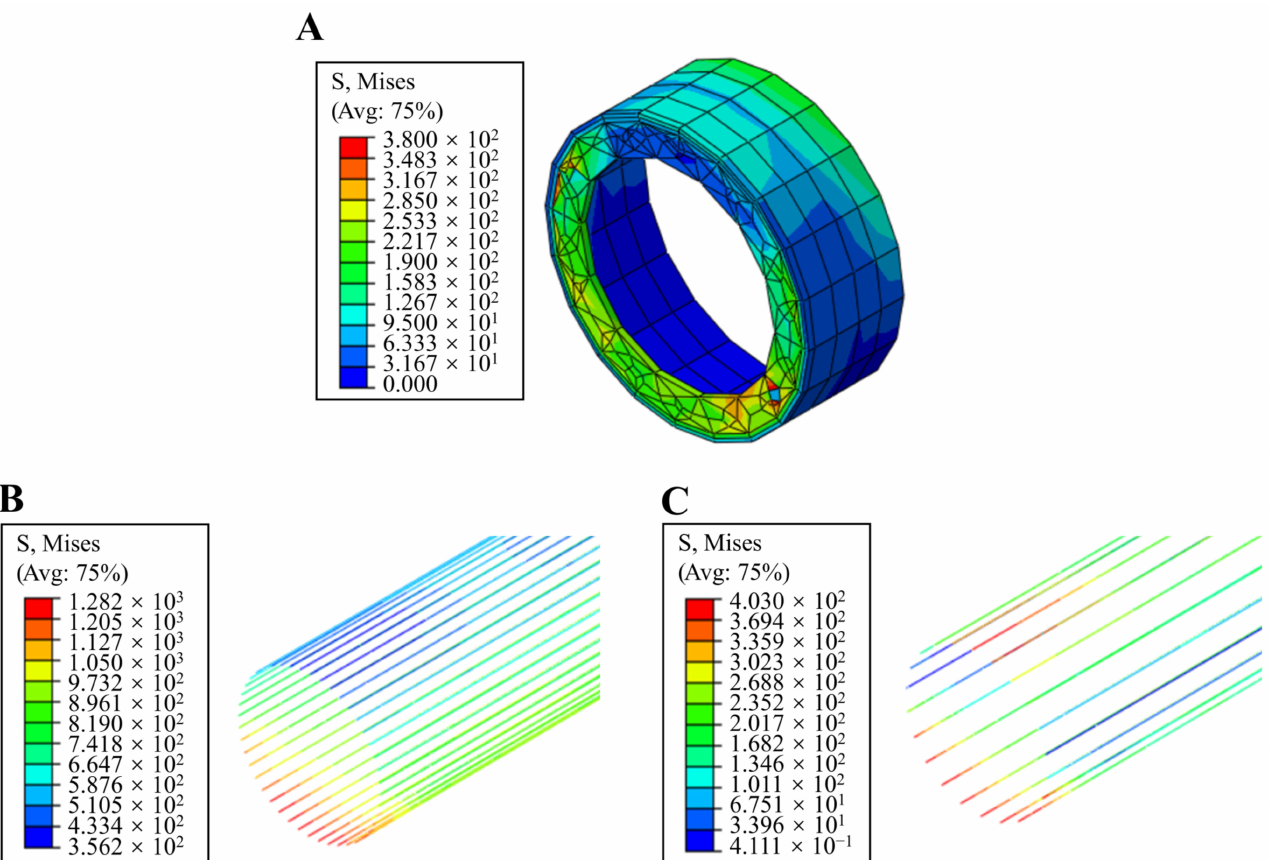
Figure 11. Stress characteristics of pipe pile joint JT1 (unit: MPa): ( A ) pile hoop and end plate; ( B ) prestressed steel rods; ( C ) non-prestressed